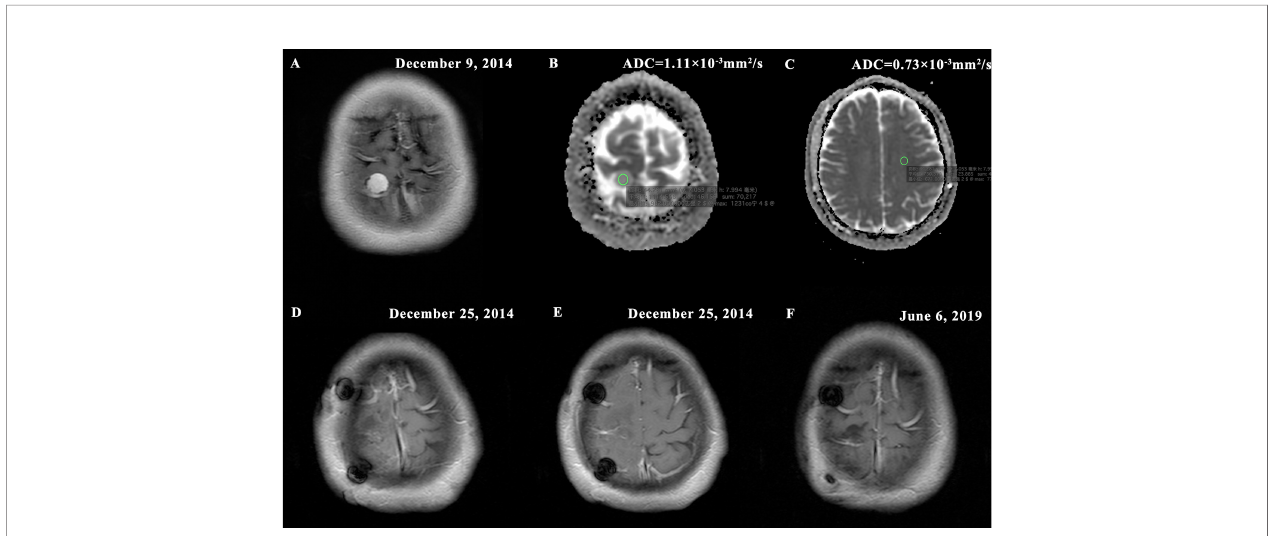
FIGURE 7 | Typical MR images of a WHO II grade meningioma with non-invasive biological behavior demonstrating (A) homogeneous enhancement (presurgical T1-postcontrast); (B) high tumor apparent diffusion coef fi cient (ADC) = 1.11×10-3mm2/s (ADC map); (C) contralateral normal appearing white matter (NAWM) ADC = 0.73×10-3mm2/s and rADC = 1.52; (D – E) Simpson grade I resection (postsurgical T1-postcontrast); (F) no imaging manifestation of tumor recurrence (postoperative T1-postcontrast). The new risk strati fi cation puts the patient in the low risk group for recurrence (nomogram score = 50). The patient was followed up for 55 months without tumor